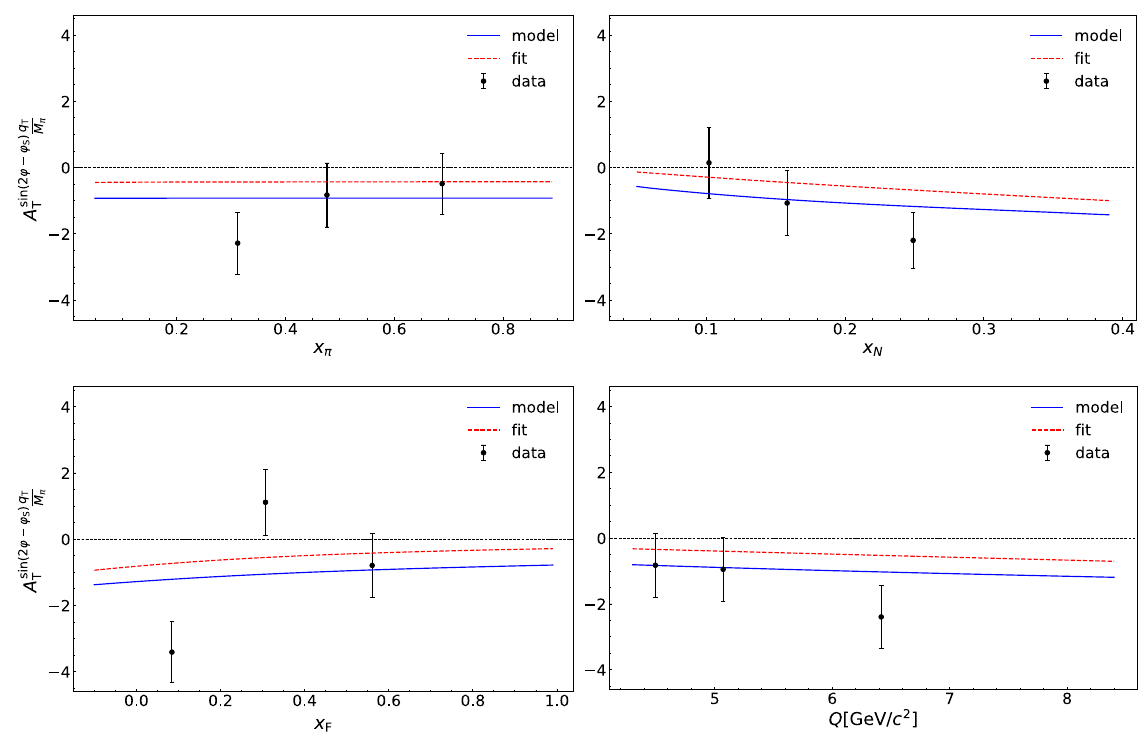
Fig. 3 Theoretical calculations and experimental statistical errors on the q T -weighted sin ( 2 ϕ − ϕ S ) asymmetries in various kinematic dependence for a DY measurement π − p ↑ → μ + μ − X with a 190 GeV / c π − beam in the high-mass region 4 GeV / c 2 < M μμ <